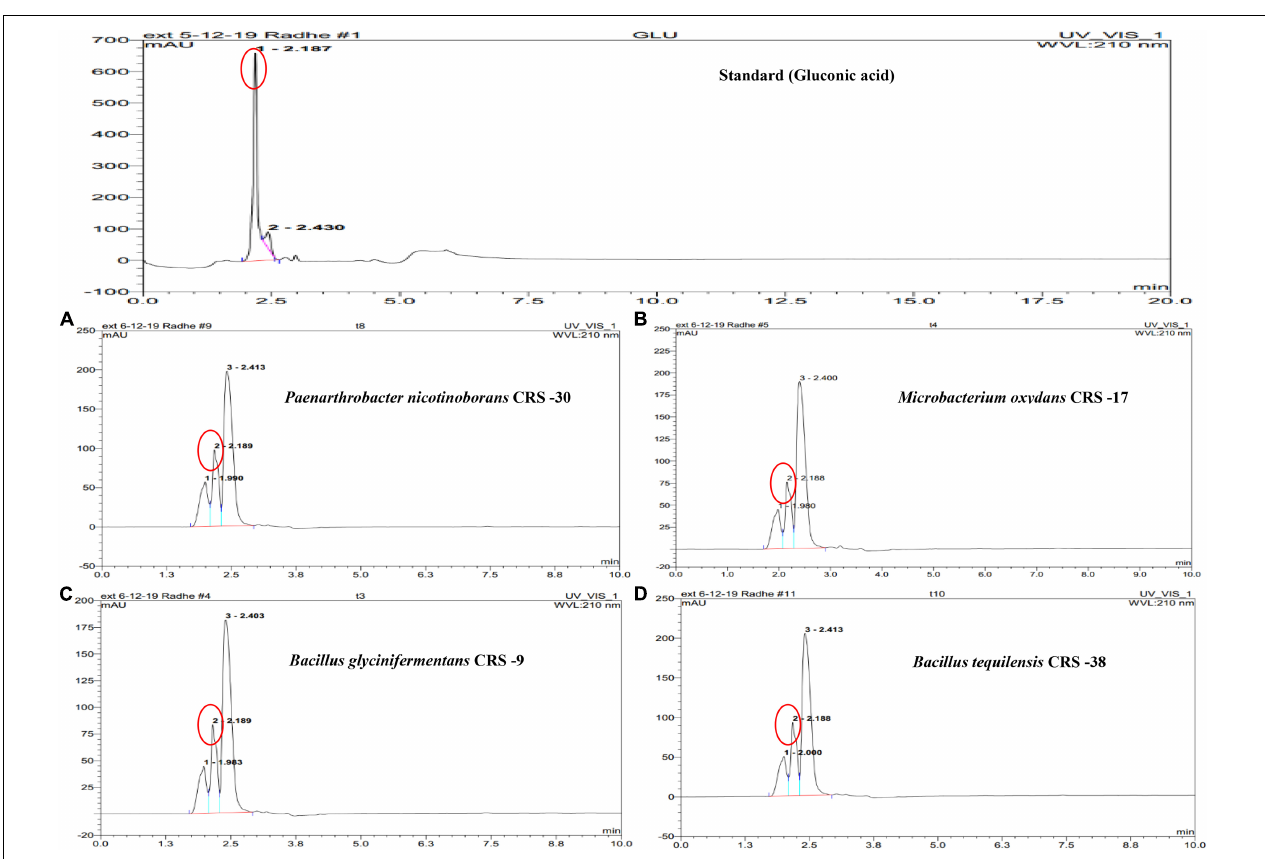
FIGURE 1 | High-performance liquid chromatography (HPLC) chromatogram depicting the peaks of gluconic acid secreted by zinc-solubilizing rhizobacteria. Chromatograph of gluconic acid as standard (top) for a comparative study on its retention time (2.18 min) with the selected strains. Chromatographs of the samples of strains (A) CRS-30, (B) CRS-17, (C) CRS-9, and (D) CRS-38 of the 10-day cultured supernatant. Peak identified as gluconic acid is indicated through circle.